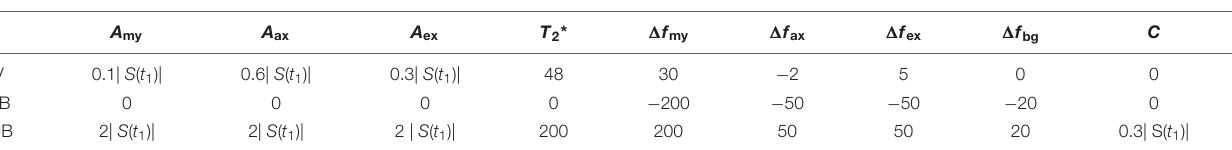
TABLE 2 | Conditions used for the optimization of model